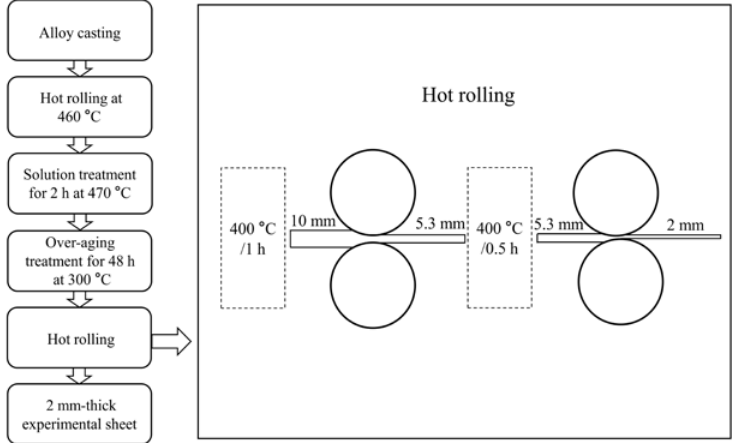
Figure 1. Schematic illustration for preparing the hot rolled Al-5Mg-2Li-0.2Sc-0.12Zr alloy sheet.